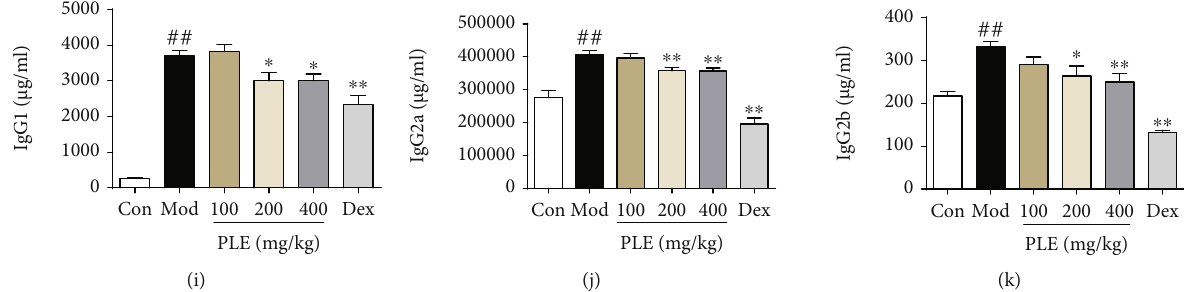
Figure 1: PLE exerted anti-in fl ammation e ff ect in allergic asthma in vivo . (a) Representative images showing pathological changes in lung tissues determined by H&E staining (magni fi cation, × 100). (b) The scores of in fl ammatory cell in fi ltration in lung tissues ( n = 15 independent slices from three mice of each group). (c) WBC, LYM, MONO, NEUT, and EOS counts in BALF ( n = 8 ). (d – g) The level of IL-6, TNF- α , and IL-4 and the ratio of IL-4/IFN- γ in BALF ( n = 8 ). (h – k) The concentration of IgE, IgG1, IgG2a, and IgG2b in serum ( n = 8 ). ## P < 0 : 01 vs. the control group; ∗ P < 0 : 05 and ∗∗ P < 0 : 01 vs. the model